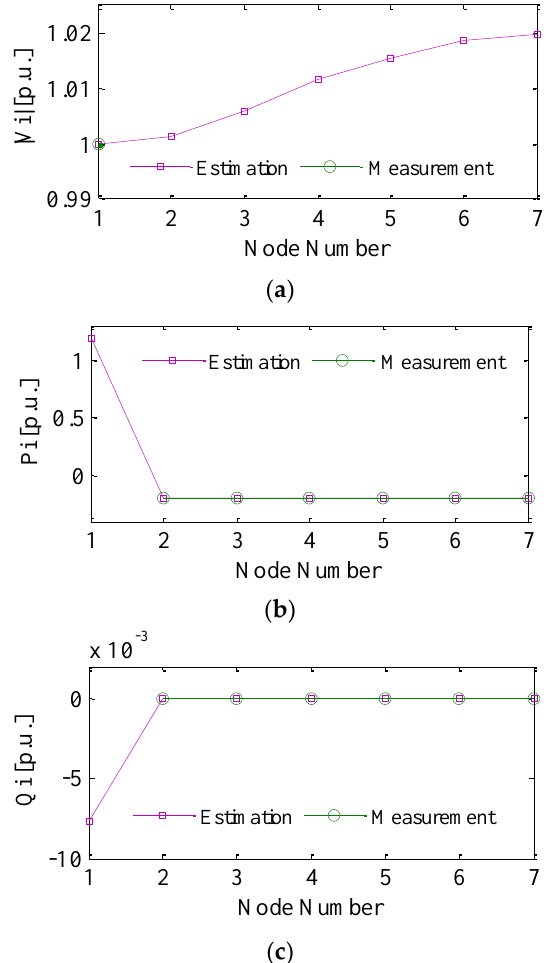
Figure 5. Estimation and measurement values using the adaptive data tolerant estimator. ( a ) |𝑉 𝑖 | ; ( b ) 𝑃 𝑖 ; ( c ) 𝑄 𝑖 .